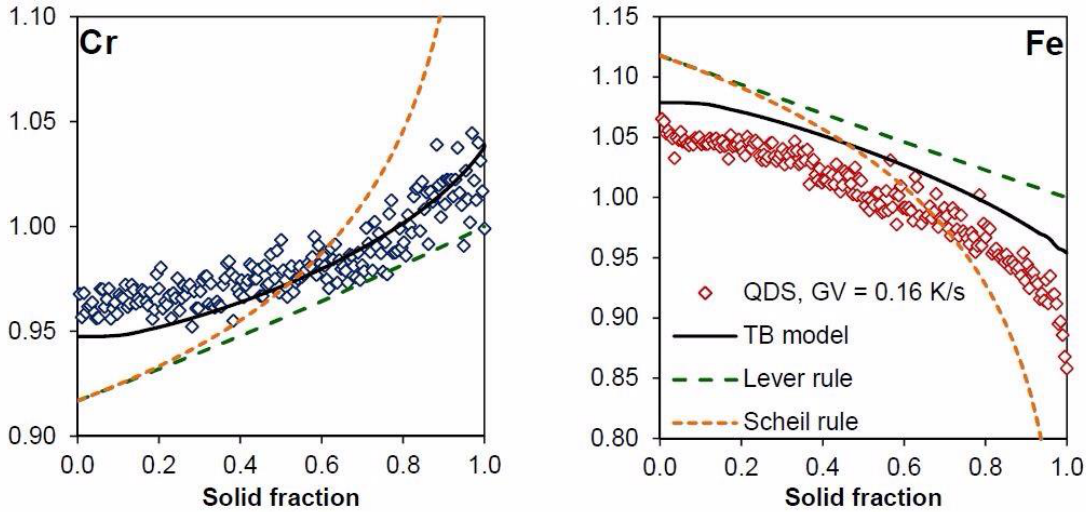
Figure 5. Comparison between microsegregation profile and Tong–Beckermann (TB) model for QDS experience for chromium and iron for GV = 0.16 K/s.